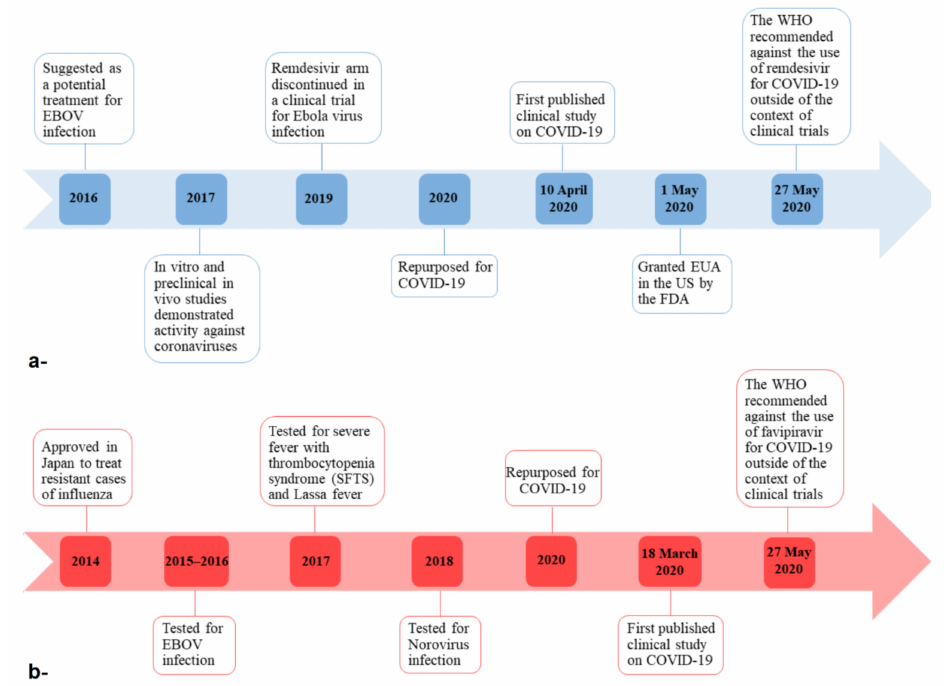
Figure 2. Timelines of remdesivir ( a ) and favipiravir ( b ) from discovery to repurposing for COVID-19. EBOV: Ebola virus; WHO: World Health Organization; FDA: Food and Drug Administration; EUA: Emergency Use